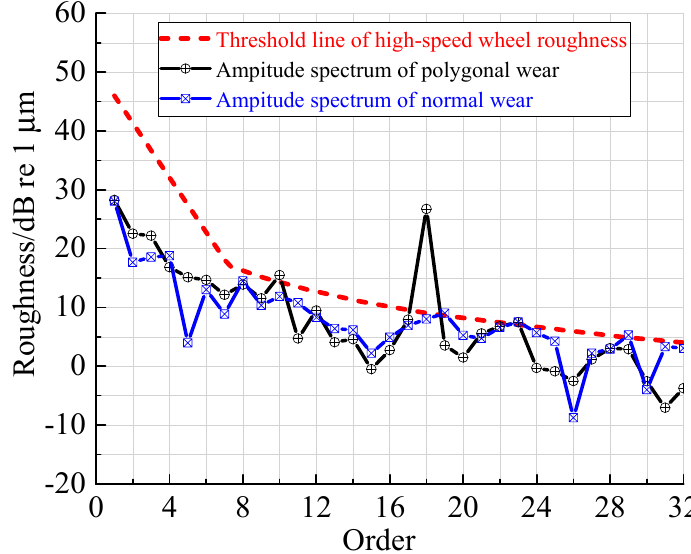
Figure 2. Statistical results of polygonal wheels.